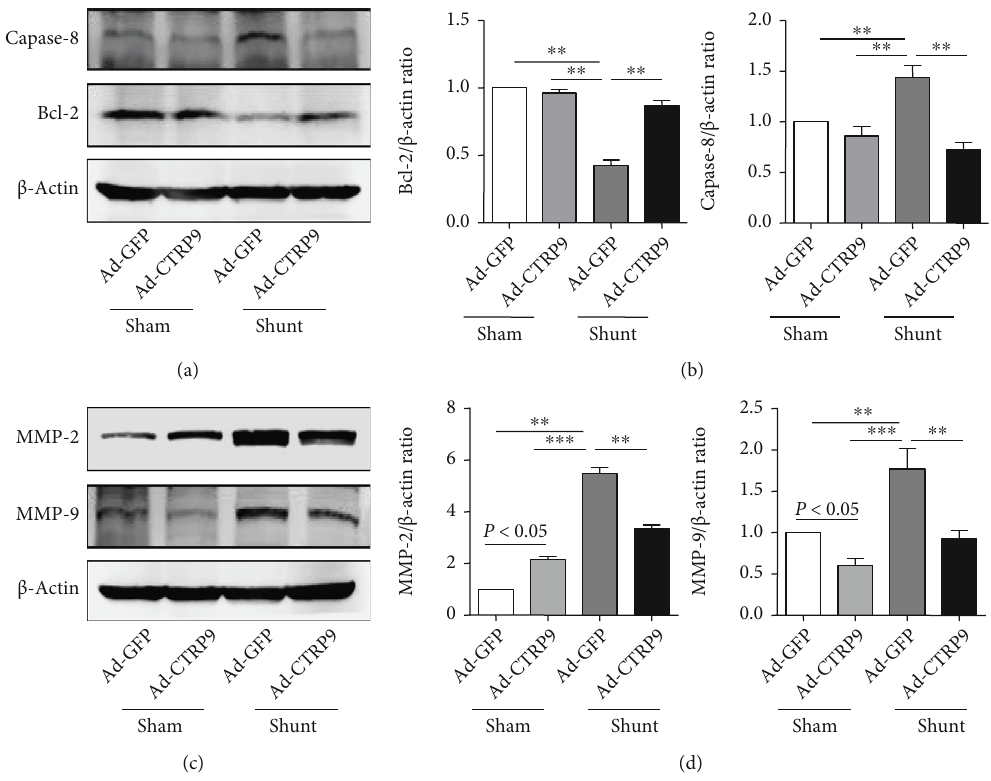
Figure 4: CTRP9 inhibits lung apoptosis and matrix injury. Wild-type rats were injected with Ad-CTRP9 or Ad-GFP, subjected to shunt or sham operation, and samples were obtained at week 12. (a, c) Caspase-8, Bcl-2, MMP-2, and MMP-9 protein expressions were analyzed by western blotting. (b, d) Representative western blots and quanti fi cation of the changes noted in caspase-8, Bcl-2, MMP-2, and MMP-9 in the lung tissues of the sham or shunt rats treated with or without CTRP9. β -Actin was used as a loading control. The data are expressed as the mean ± SEM . n = 6 for each group. A total of 6 samples were randomly selected from each group to perform western blotting. ∗ P < 0 : 05 , ∗∗ P < 0 : 01 , and ∗∗∗ P < 0 : 001 vs. the Ad-GFP-sham group. CTRP9: C1q/TNF-related protein 9; Ad-CTRP9: adenovirus-CTRP9; Ad-GFP: adenovirus GFP; Bcl-2: b-cell lymphoma; MMP: matrix